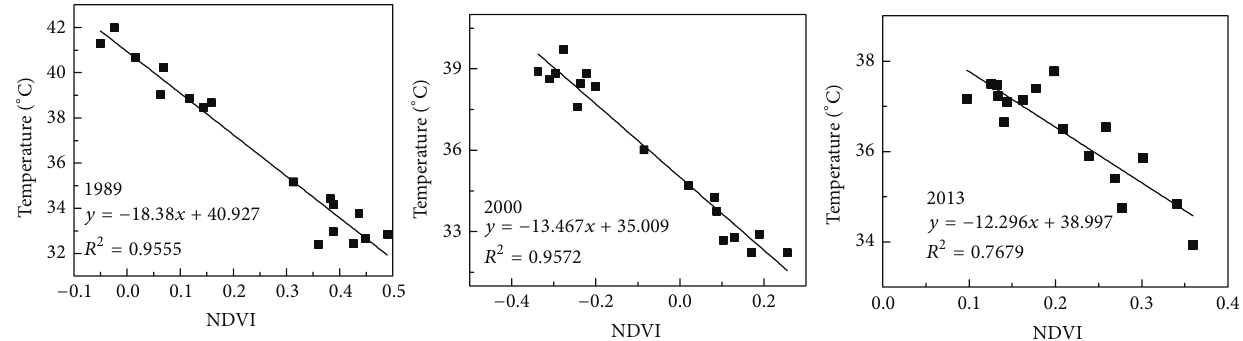
Figure 11: Correlation between LST and NDVI ( 𝑥 : mean NDVI; 𝑦 : mean